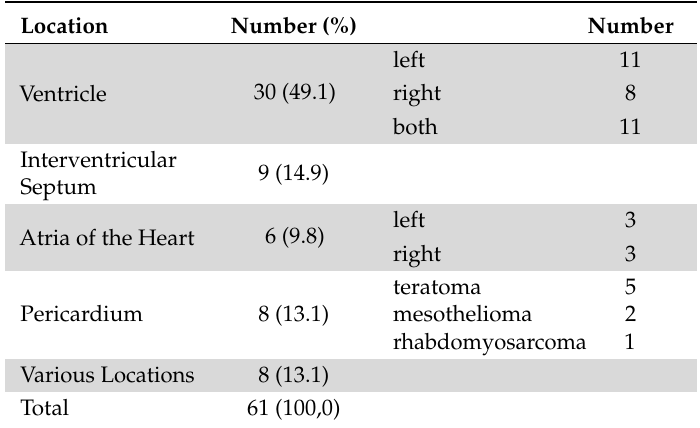
Table 4. Location of tumors.